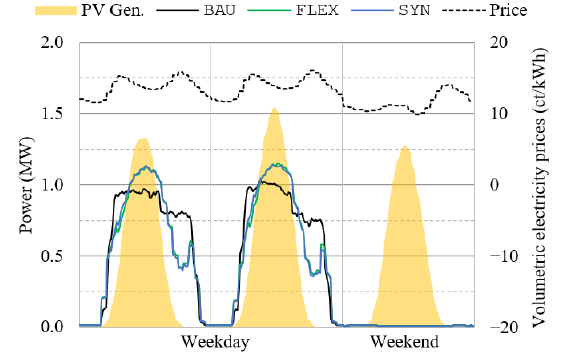
Figure 7. Average on-site electricity demand, PV generation and electricity prices of exemplary weekdays and